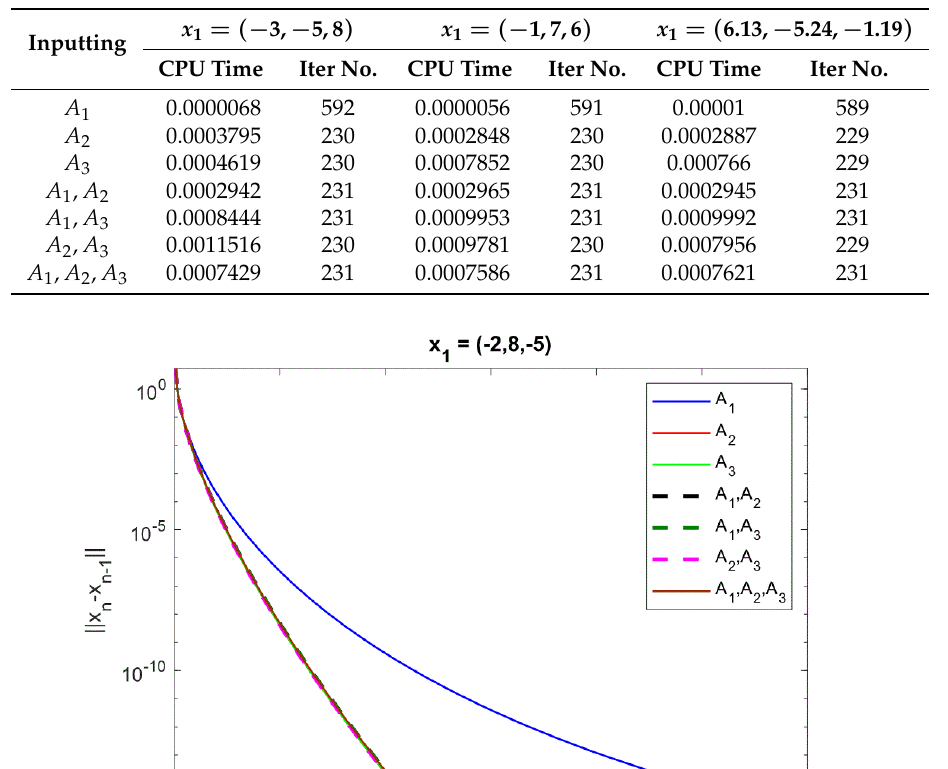
Table 1. Comparison of the number of iterations in Example 1.